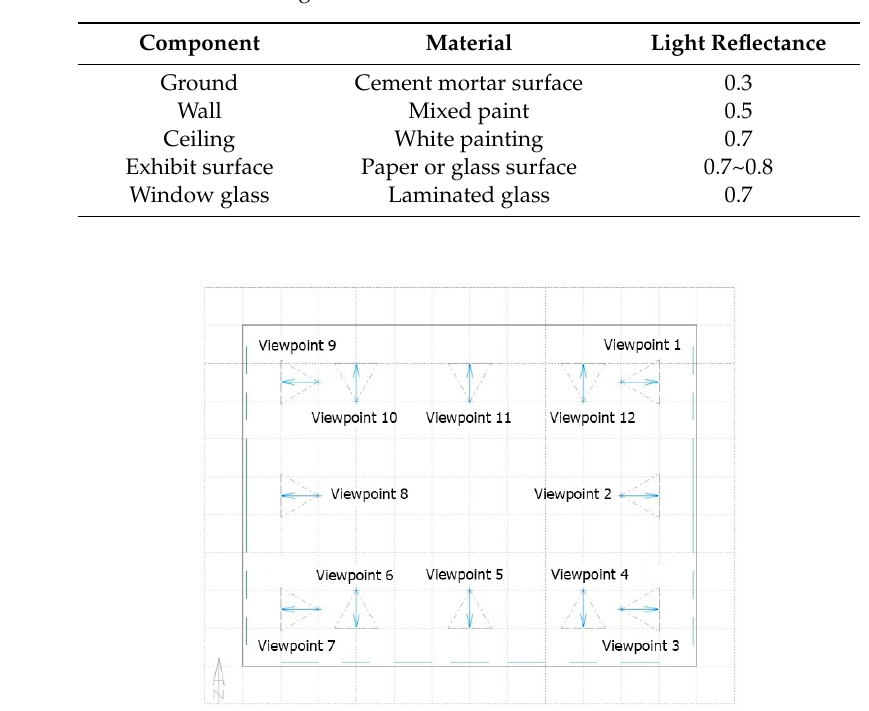
Figure 9. Planar arrangement of viewpoints.